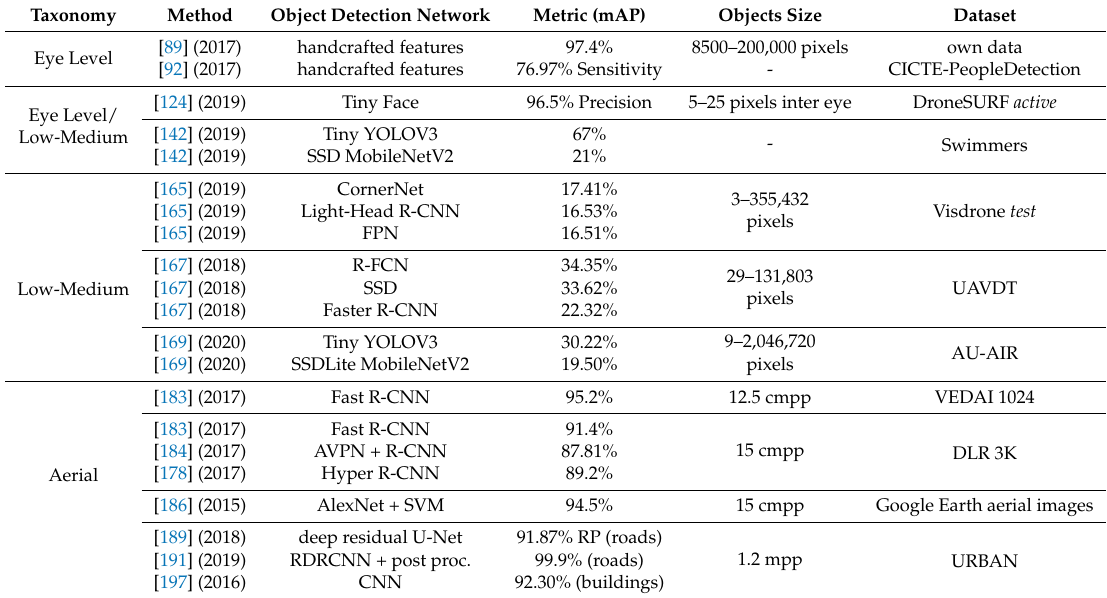
Table 1. Summary of selected object detection methodologies at different flight heights. RP stands for Relaxed Precision as introduced in [188], cmpp stands for cm per pixel and mpp stands for meters per pixel .